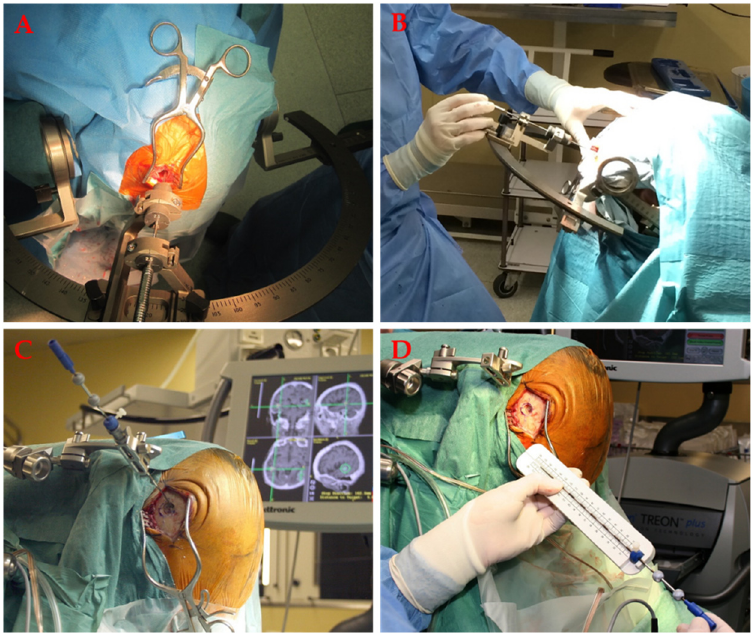
Figure 7. ( A ) Frame-assisted stereotactic biopsy for deep-seated brain lesions. The stereotactic arch with the attached biopsy guidance introductor is visible. ( B ) The insertion of the biopsy needle. ( C ) Frameless stereotactic biopsy. The trajectory is adjusted during the procedure according to neuronavigational panning. ( D ) The biopsy needle for frameless stereotactic biopsy and needle length adjustment.